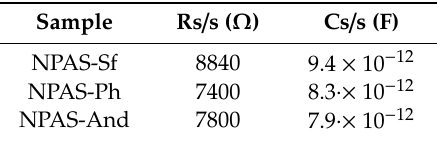
Table 5. Values determined for the electrical resistance and capacitance of the three 0.002 M NaCl solution / sample (s / s) systems.